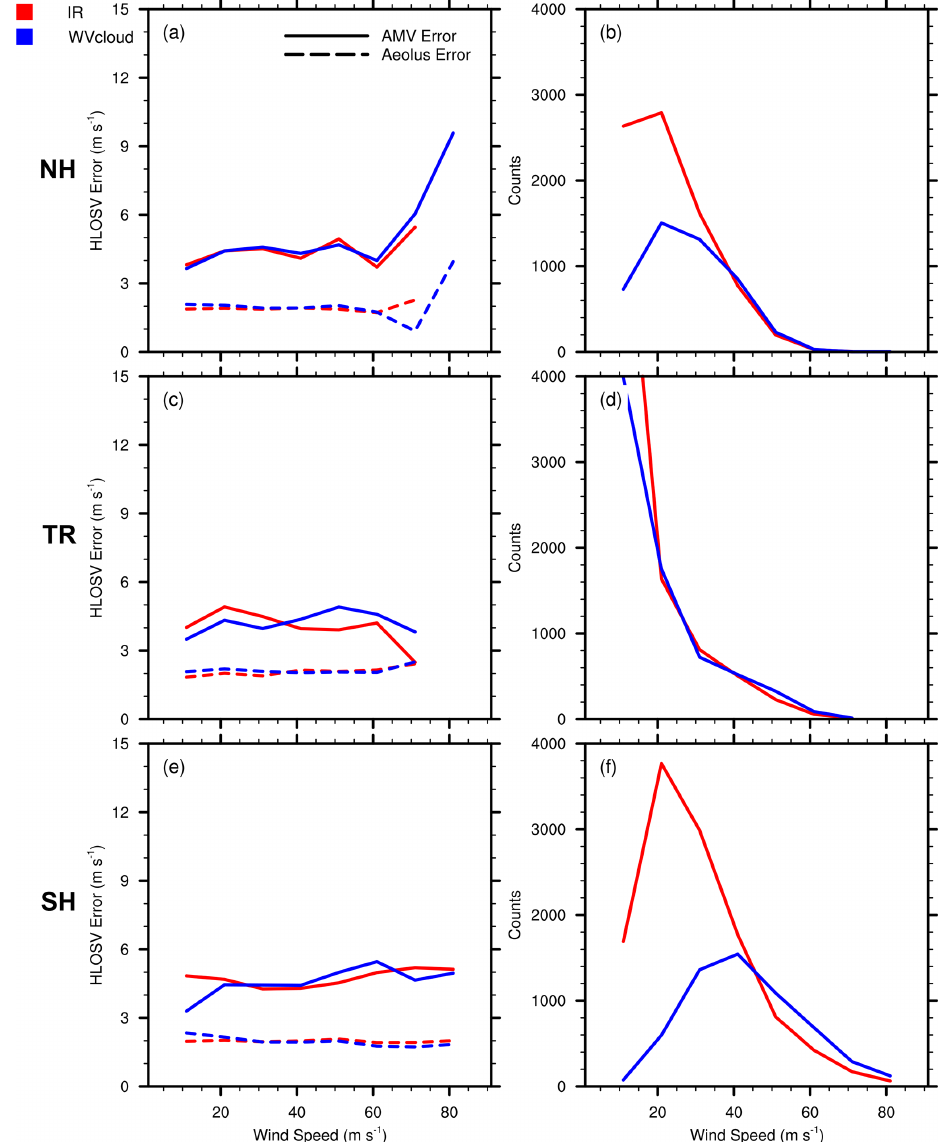
Figure 11. As in Fig. 8 but for MIE comparisons with GOES-16 IR (red) and WVcloud (blue)